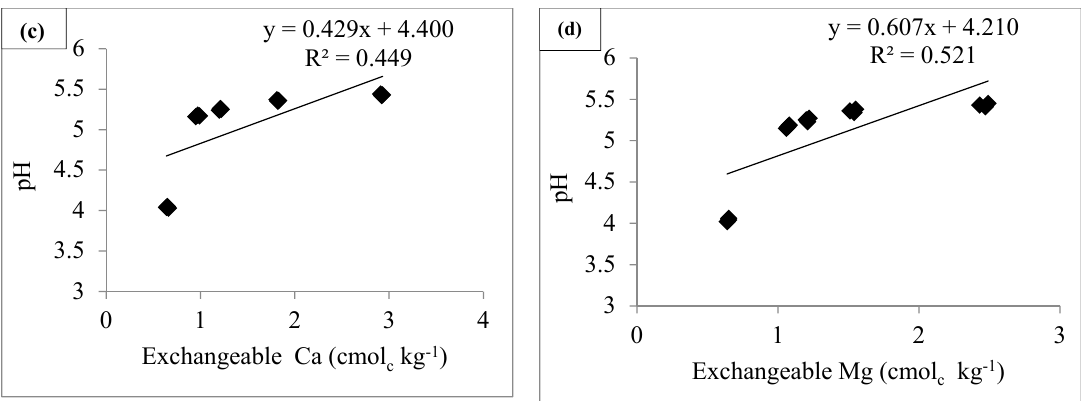
Figure 3. Relationship between soil pH and exchangeable Al ( a ), soil pH and extractable Fe ( b ), soil pH and exchangeable Ca ( c ) and soil pH and exchangeable Mg ( d ).